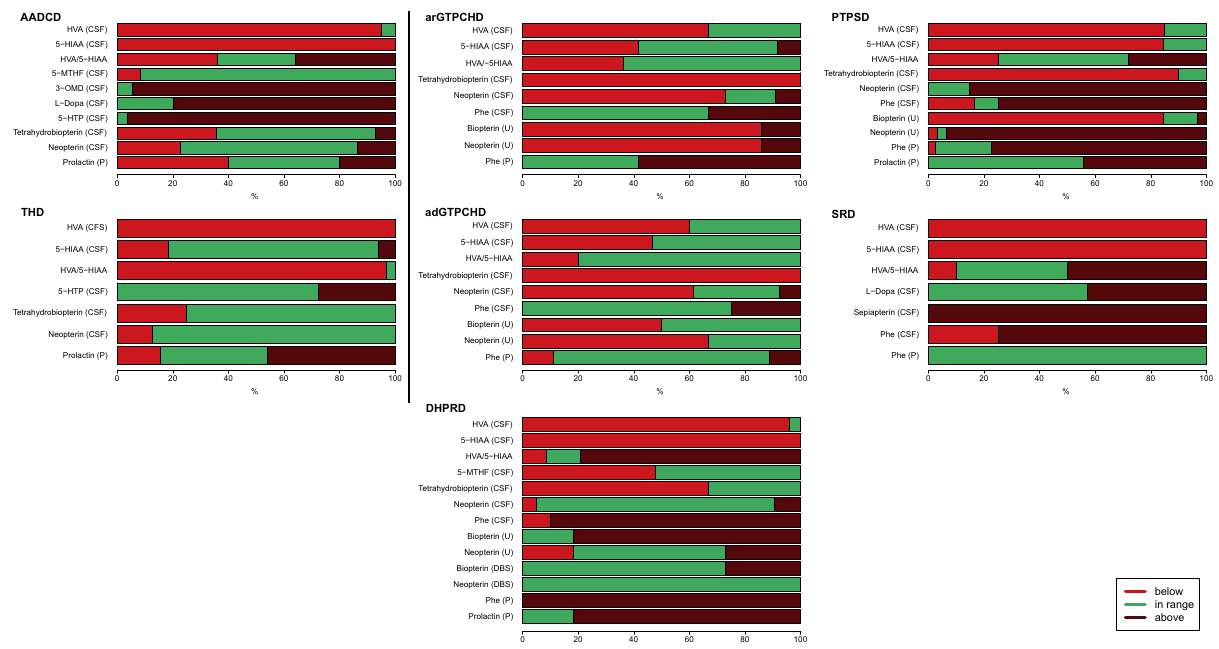
Fig. 6 Biochemical pattern. Disease-speci fi c changes of biochemical parameters in plasma (P), dried blood spot (DBS), urine (U) and cerebrospinal fl uid (CSF) before